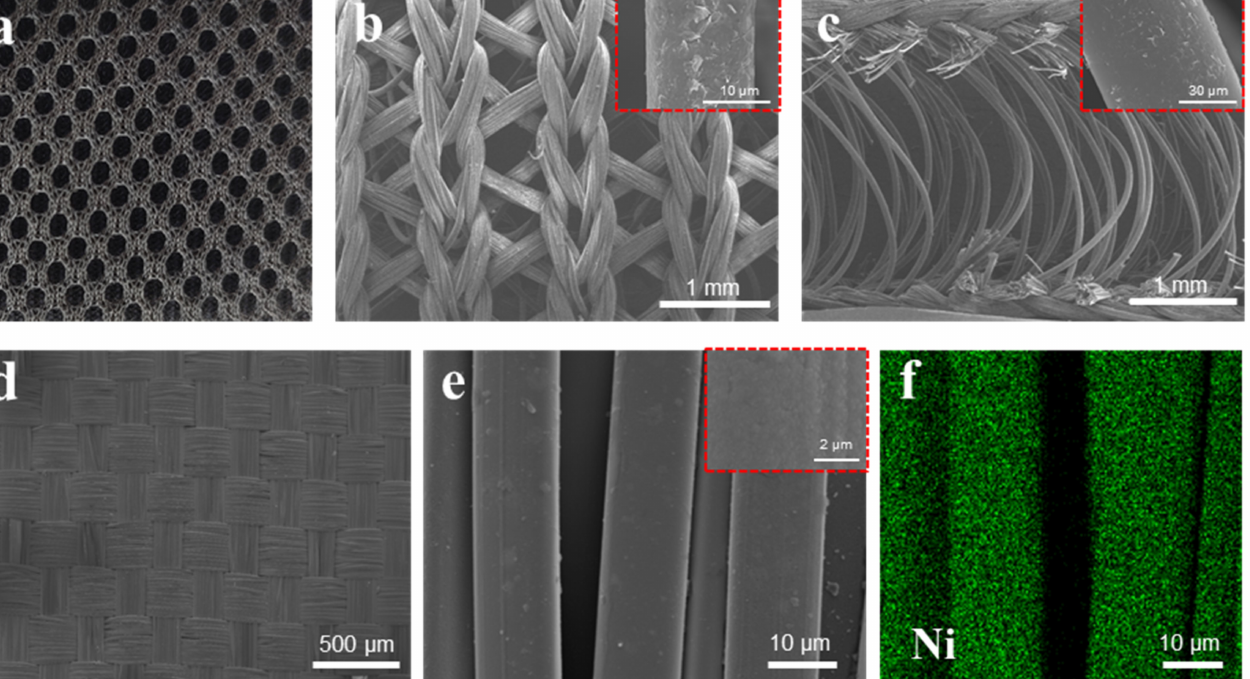
Figure 2. Photographs of the typical surface morphology: ( a ) upper honeycomb structure images of the GHF dielectric layer; FESEM images of ( b ) the lower compact knitted structure and ( c ) the supporting yarn of the GHF; ( d , e ) the woven structure; ( f ) energy dispersive spectroscopy (EDS) mapping of the nickel-plating fabric